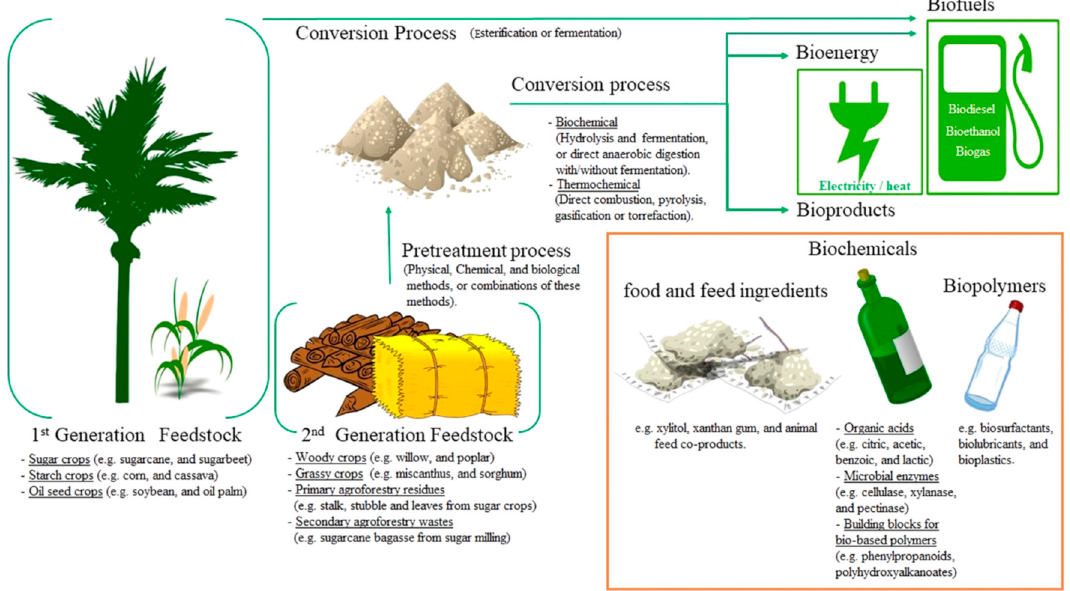
Figure 2. Schematic diagram shows the differences between lignocellulosic feedstocks from the first and second generations: sources, valorization processes, and end products. Reproduced with permission from [13], Elsevier, 2019.